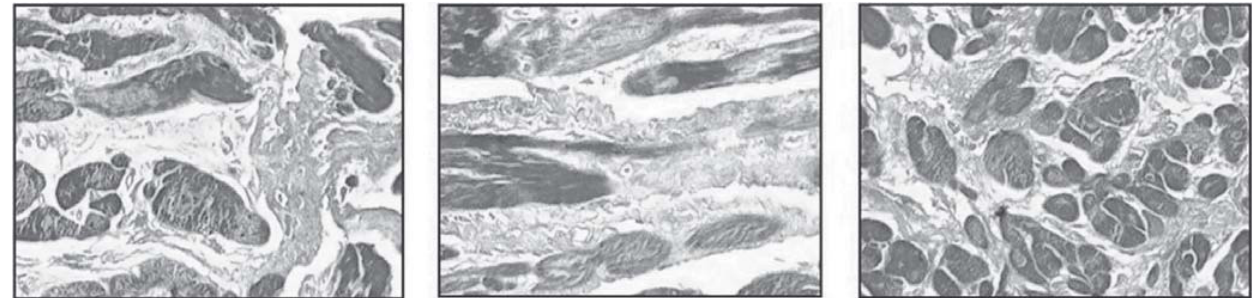
Fig. 4 - A pattern of increased interstitial collagen (light). The myocardial fibers are the darkest (T.Masson)